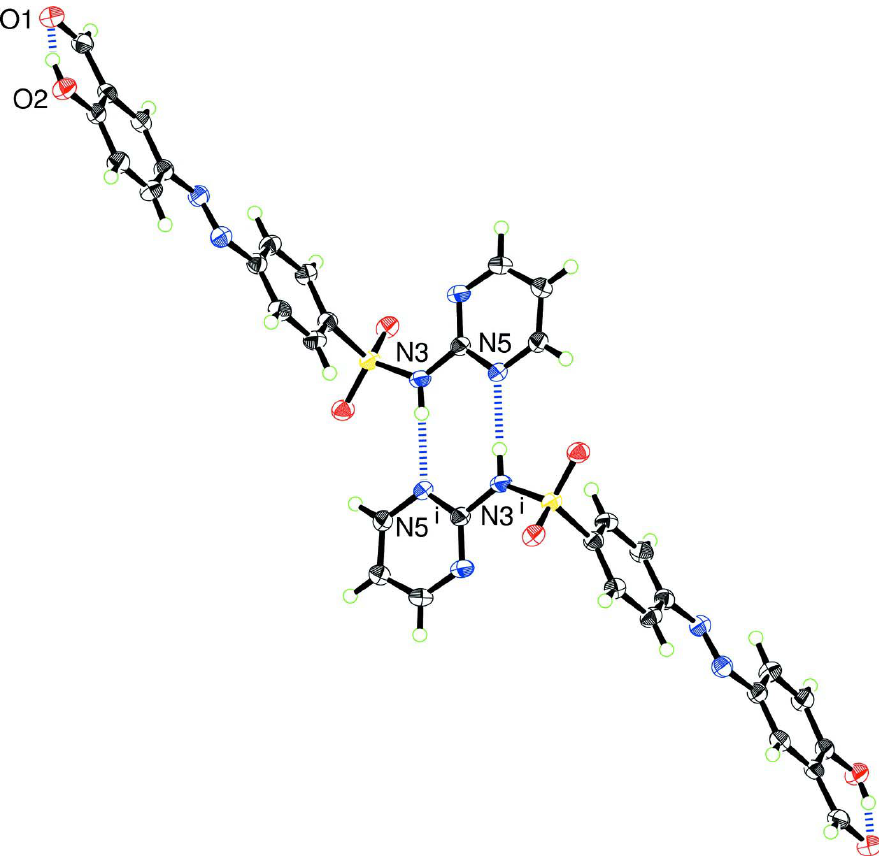
Figure 2 Part of the crystal structure showing a pair of molecules [symmetry code: (i)1 - x , 2 - y , 1 - z ] stabilized by intra- and intermolecular hydrogen bonds (dashed